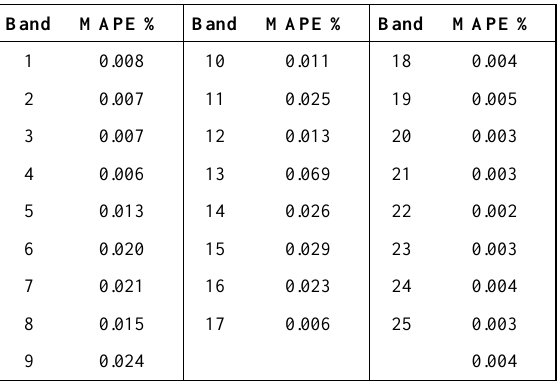
Table 5. MAPE% obtained from the radiometric resolution reduction to 16